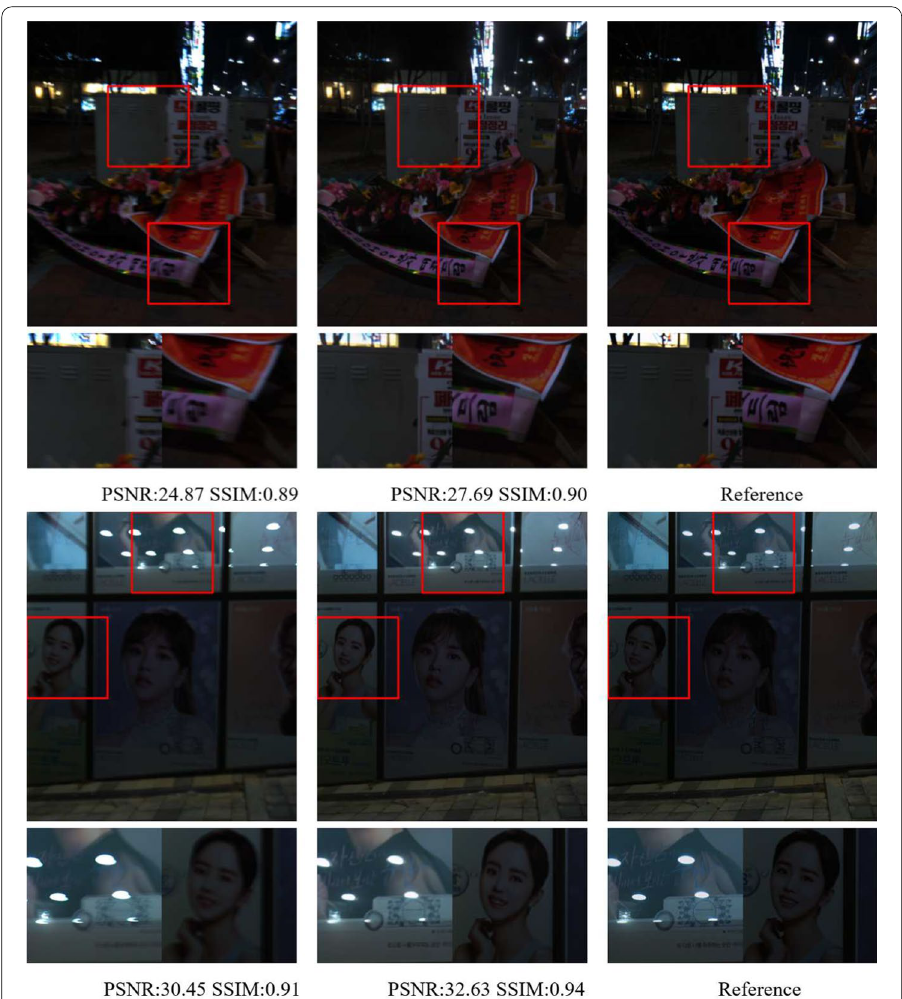
Fig. 7 Results on the RealBlur-R test dataset. From left to right: blurred, our deblurred, sharp photograph